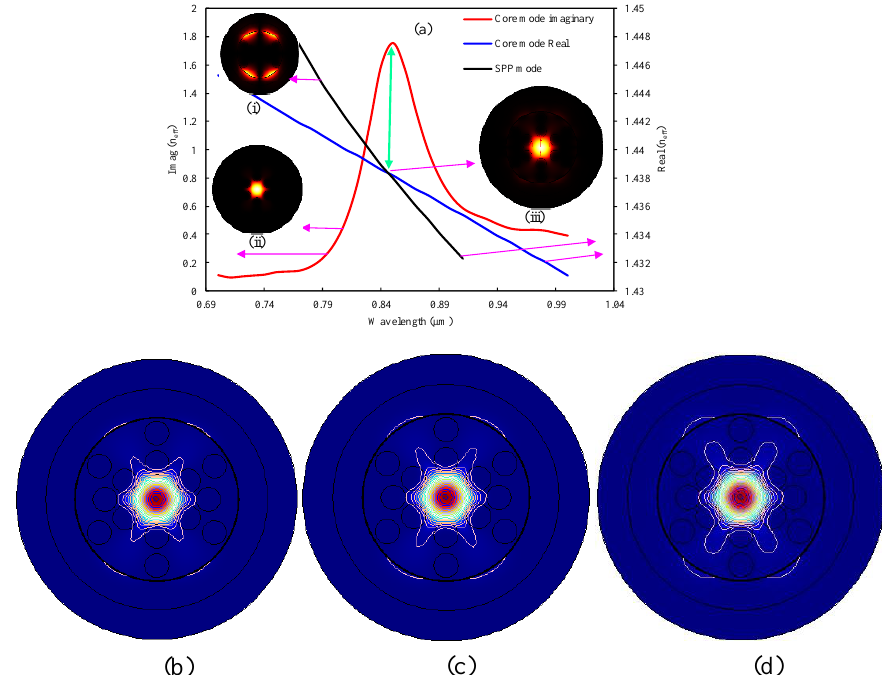
Figure 3. Complex refractive index (RI) of the sensor and optical field distribution ( a ) (inset ( i ) SPP mode, ( ii ) core mode, and ( iii ) resonance condition) for analyte RI of 1.39, ( b–d ) representation of coupling strength for different analyte RIs from 1.38–1.40 with using the optimized sensor parameters.